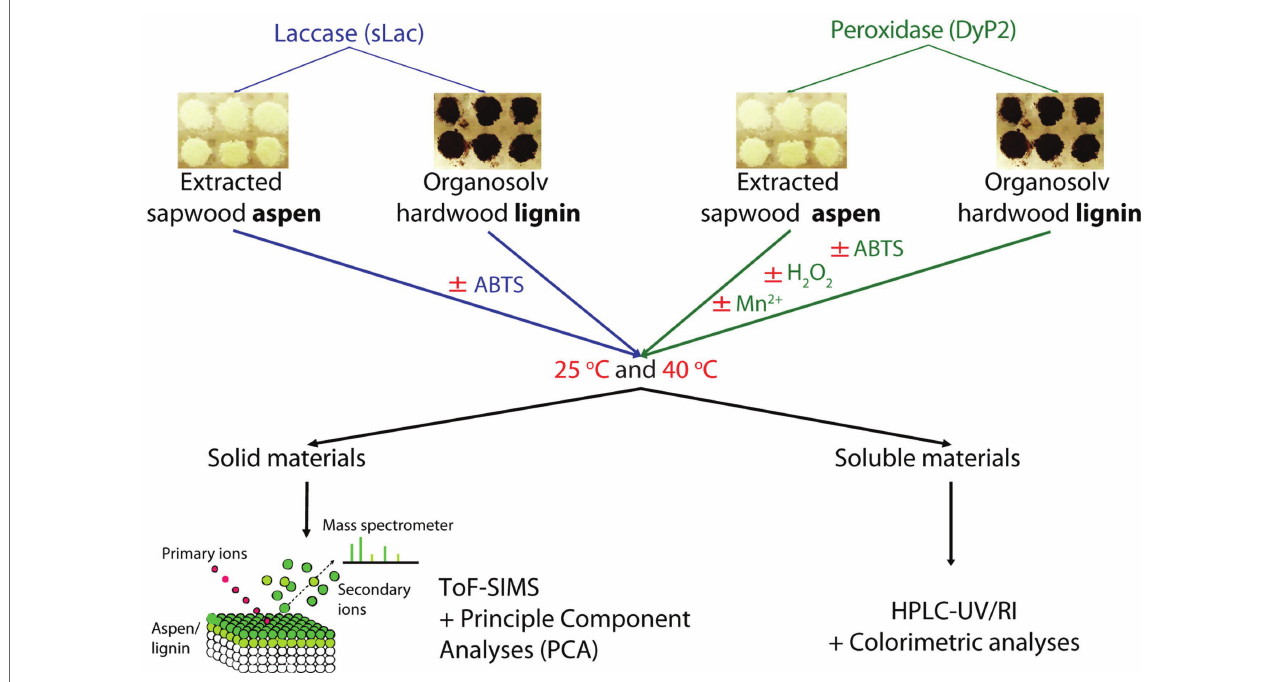
FIGURE 1 | Flowchart for analyzing activity of sLac and DyP2 on organosolv lignin and wood powder. Both enzymes were incubated at 25 and 40 ° C with and without co-substrates/mediator. The reactions were filtered through a 1.2 μ m PVDF membrane: the filtrates were then analyzed by HPLC-UV/RI and spectrophotometry while the remaining solid samples were analyzed by